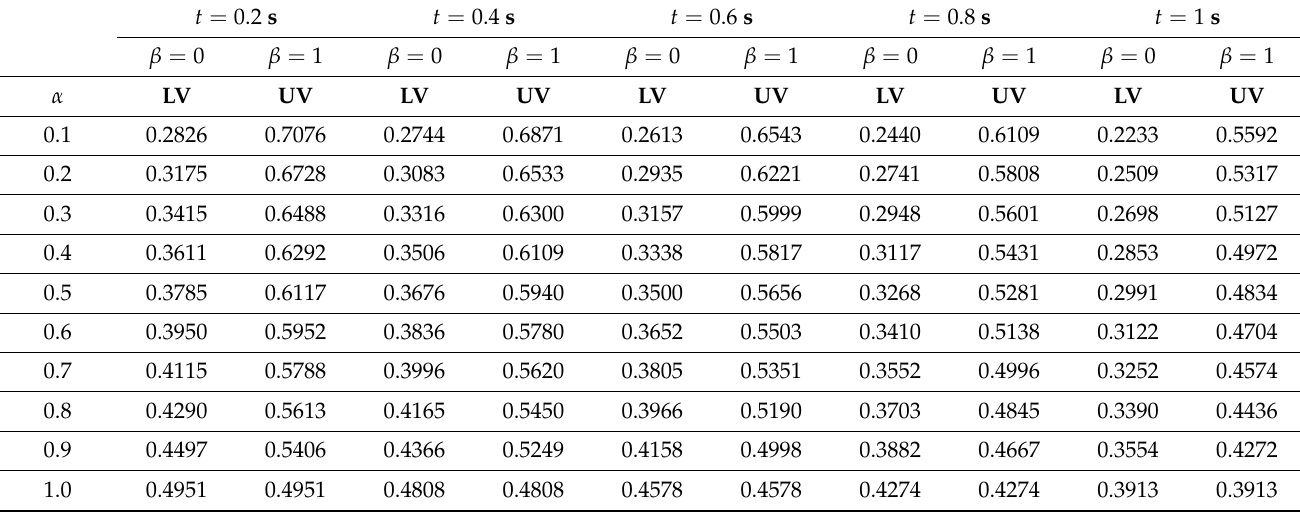
Table 6. Fuzzy solution of η for h =